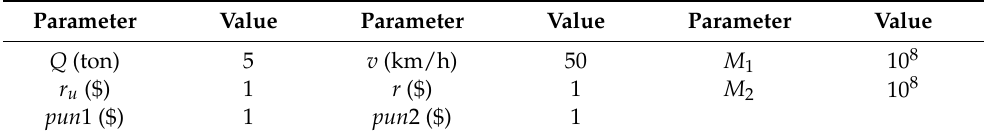
Figure 7. Distributions of customers, Hiland Dairy, and Charging stations in Dallas, TX, USA. Table 7. Routing parameters in Table 8. The performances of the NR-EGA.